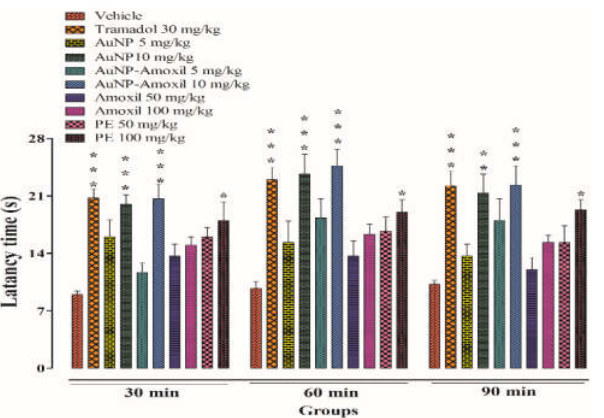
Figure 9. Thermally induced antinociceptive pain in mice using hot plate. Bars represent mean ± SEM. * p < 0.05, ** p < 0.01, *** p < 0.001 compared to the vehicle treated animals. Data were analyzed by one-way ANOVA followed by Tukey’s